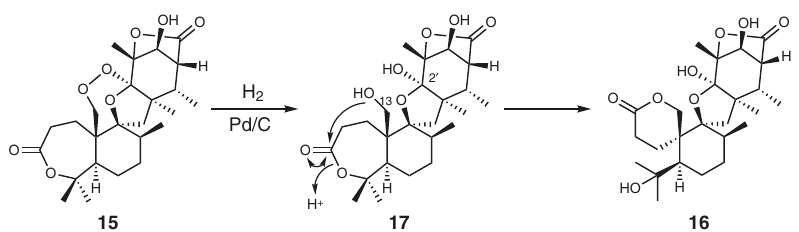
Fig. 3 Palladium-catalyzed hydrogenolysis of 15 . Reductive cleavage of the endoperoxide proved the presence of the endoperoxide linkage in